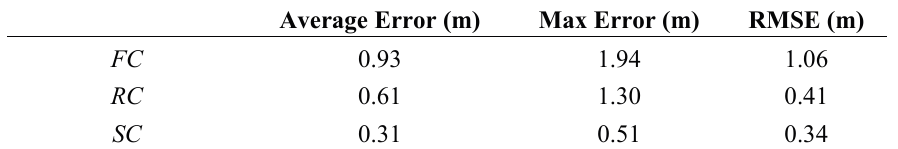
Figure 7. Geometric error of leading points and referenced points. ( a ) Geometric error of leading points (black triangles) and referenced points (green circles) by using FC (fixed corner, without the shiftable leading point) (red lines represent error vectors, which are amplified 10 times); ( b ) geometric error of leading points (black triangles) and referenced points (green circles) by using RC (RANSAC; removed points in the box); ( c ) geometric error of leading points and referenced points by using SC (shifted corner, with the shiftable leading point), after the 10th iteration; ( d ) change of the geometric error of leading points and referenced points with iterations by using SC . Table 3. Evaluation of the geometric precision of leading points and referenced